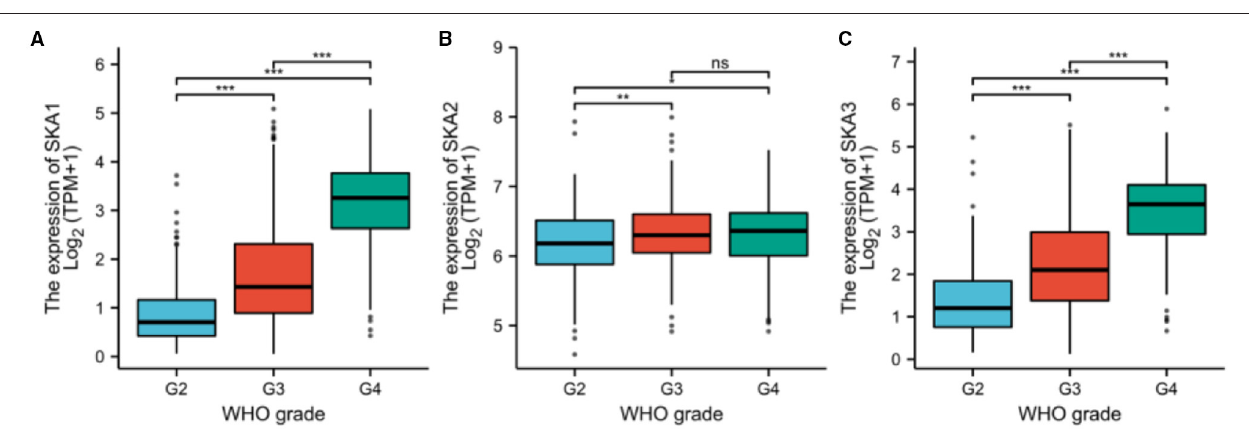
FIGURE 3 | The expression of (A) SKA1, (B) SKA2, and (C) SKA3 in G2, G3, and G4 gliomas included in the UALCAN database. The grouping is based on WHO classification. ** p < 0.01; *** p < 0.001; ns, not significant. mainly enriched in the cell cycle and DNA replication